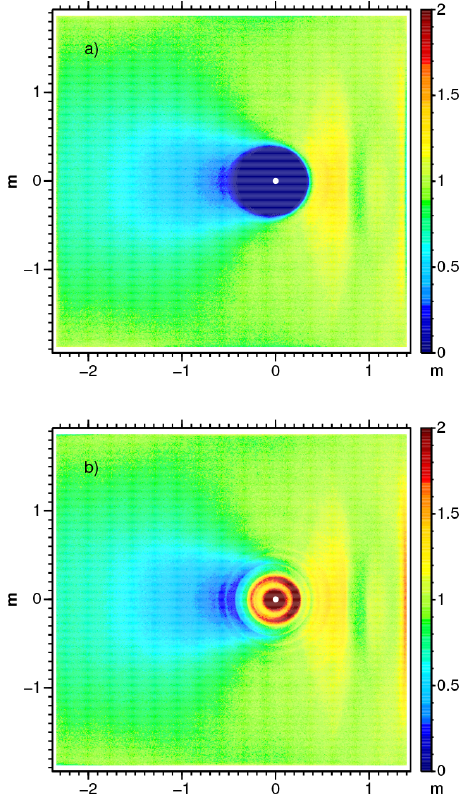
Figure 11. Electron density (a) and ion density (b) normalised to plasma-stream density in the final state ( t = 2 . 43ms) of run Proton.